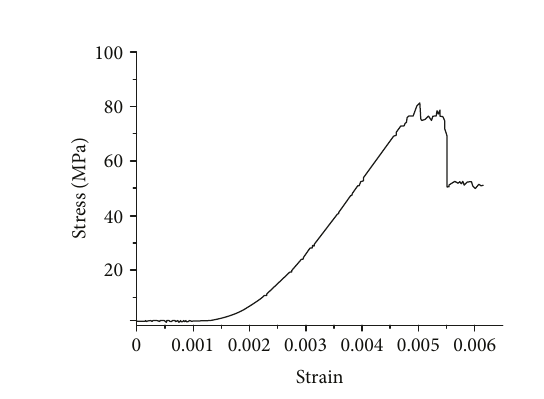
Figure 2: Stress-strain curve of ore rock.